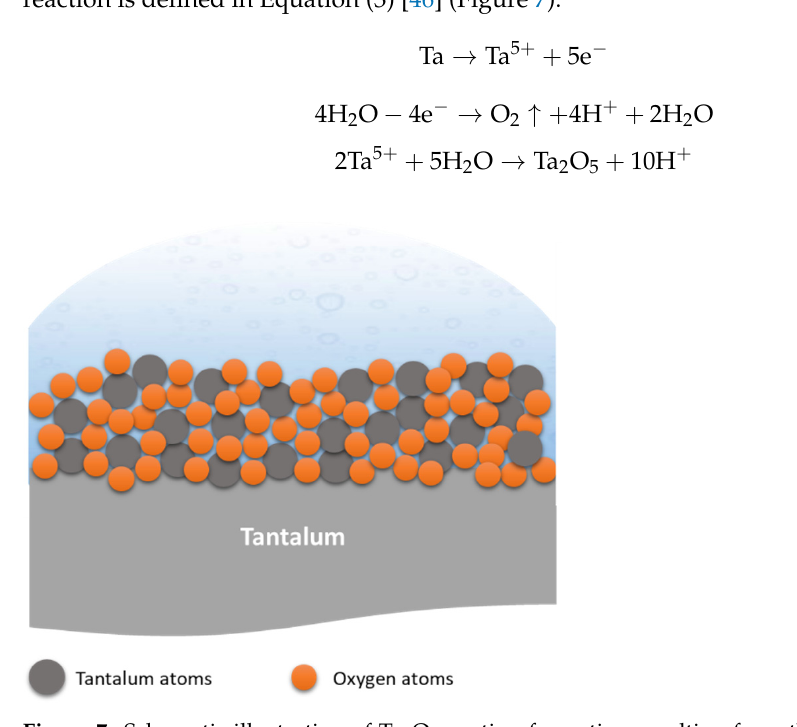
Figure 7. Schematic illustration of Ta 2 O 5 coating formation resulting from the chemical reaction described in Equation (3).